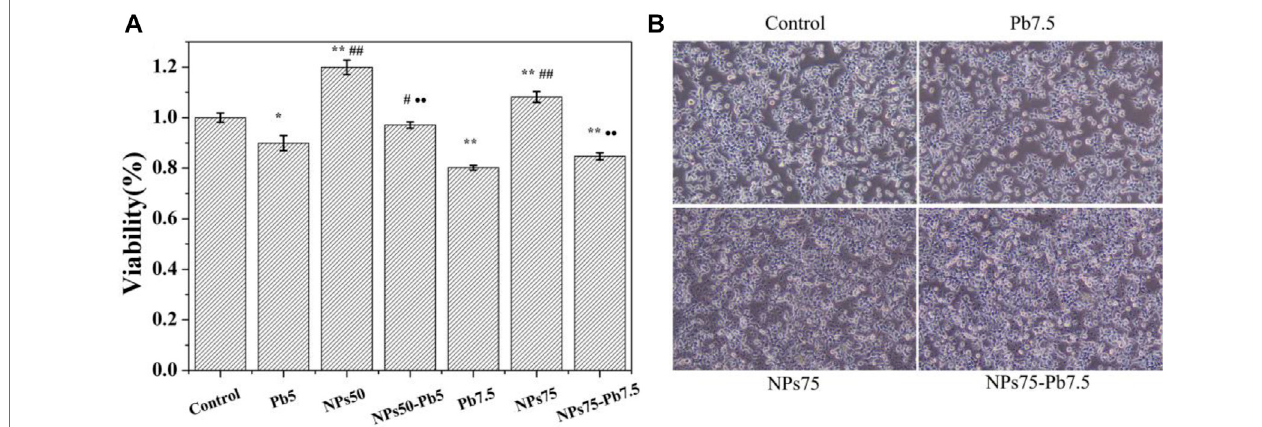
FIGURE 4 | (A) Viability of HEK293 cells. Control is the control samples. Pb5 is cells cultivated with Pb 2+ ions in the concentration of 5 μ g mL − 1 . NPs50 is cells cultivated with Fe mSiO 2 -NH 2 NPs in the concentrations of 7.5, 75 and 75 μ g mL − 1 , respectively. * vs. control (* p < 0.05 and ** p < 0.01). # vs. Pb5 or Pb7.5, corresponding to the concentrationofNPsof50or75 μ g mL − 1 ,respectively( # p < 0.05and ## p < 0.01). · vs. NPs50orNPs75correspondingtotheconcentrationofNPsof50or75 μ g mL − 1 , respectively ( · p < 0.05 and ·· p < 0.01). (B) Morphology of cell samples control, Pb7.5, NPs75, and NPs75-Pb7.5.